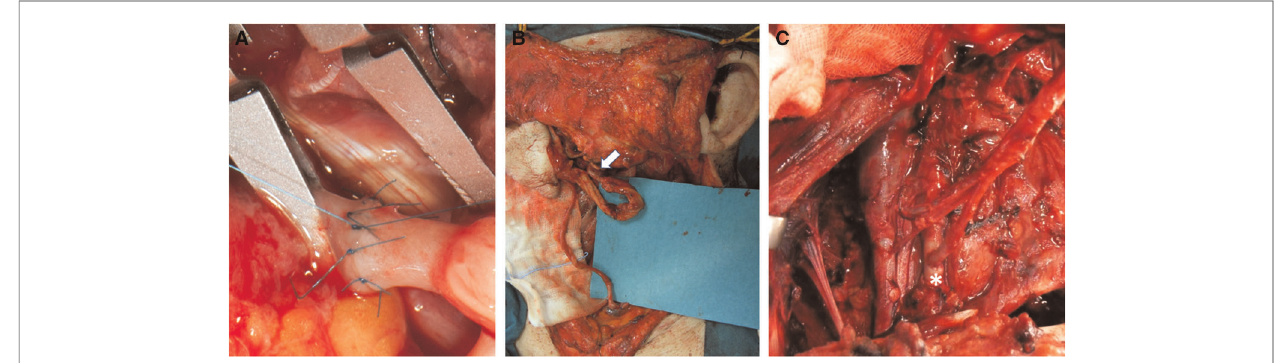
FIGURE 2 | Arterial recipient vessels. ( A ) End-to-end arterial anastomosis detail. ( B ) Anastomosis between the transected supra digastric facial artery and the radial artery fl ap pedicle (white arrow). ( C ) End-to-side anastomosis to the external carotid artery (white asterisk).